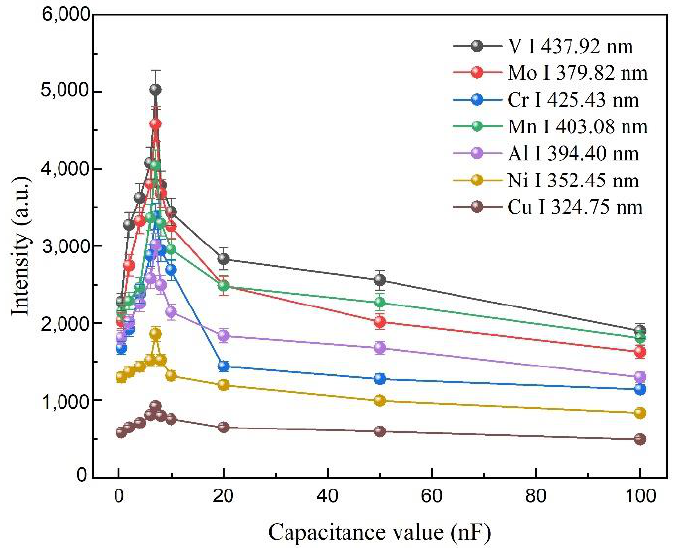
Figure 4. Plots of V, Mo, Cr, Mn, Al, Ni, and Cu elements spectrum signal intensities observed in fs LA-SIBS under different discharge capacitances.